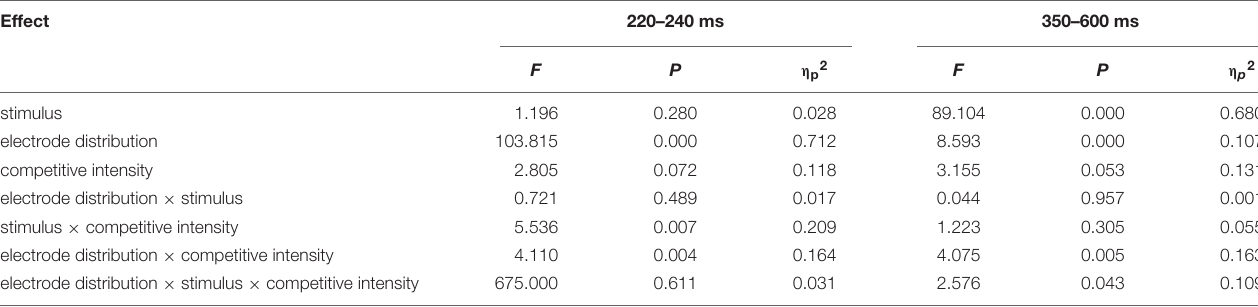
TABLE 2 | Summary of ANOVA results of N2 (220–240 ms) and LPP (350–600 ms) with the electrode distribution (frontal, central, and parietal), stimulus (pain, non-pain) as the within-subject factors, and competitive intensity (HCI, MCI, and LCI) as the between-subject factor.